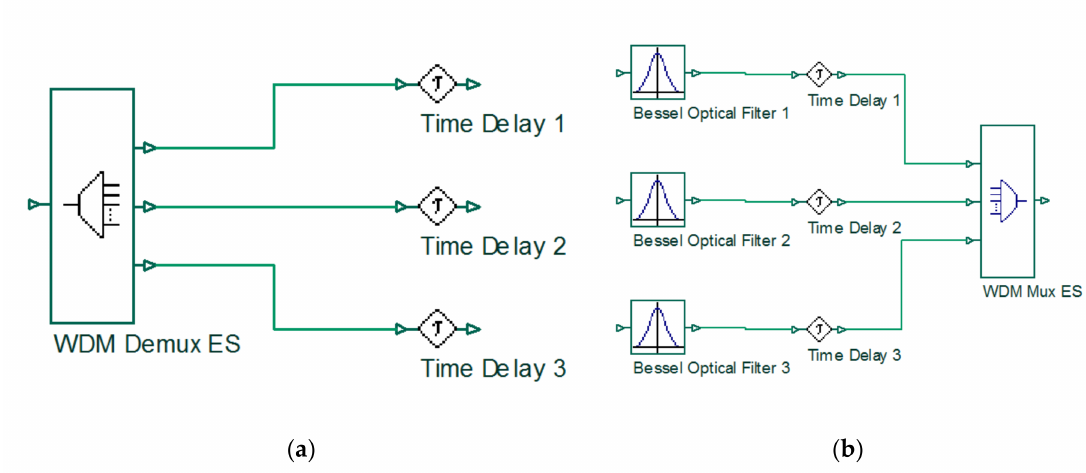
Figure 2. 2D-MD SAC-OCDMA encoder ( a ) and decoder ( b ) for user